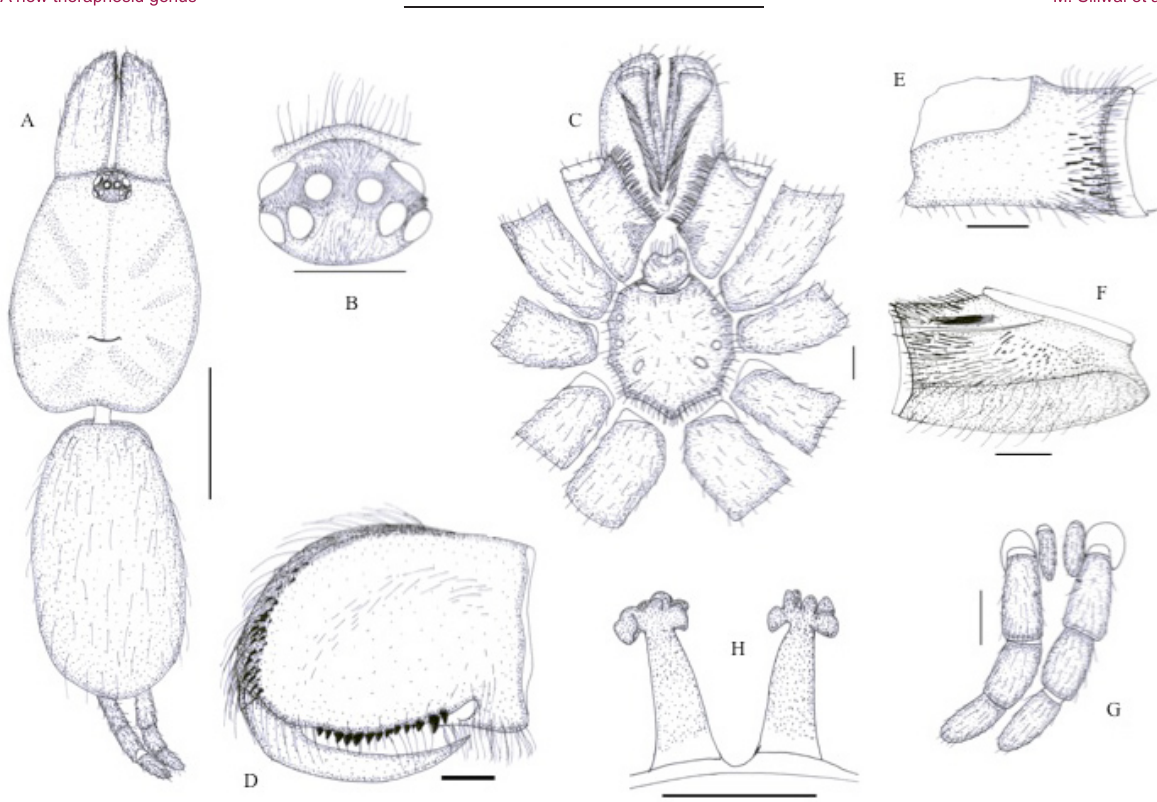
Figure 7. Neoheterophrictus uttarakannada sp. nov., female (WILD-10-ARA-923). A - Carapace and abdomen dorsal view; B - Eye; C - Sternum, maxillae, labium, chelicerae; D - Chelicerae prolateral view; E - Maxillae, retrolateral view; F - Coxa I, prolateral view; G - Spinnerets; H - Spermathecae. Scale 1.0mm for B–H and scale 0.5mm for